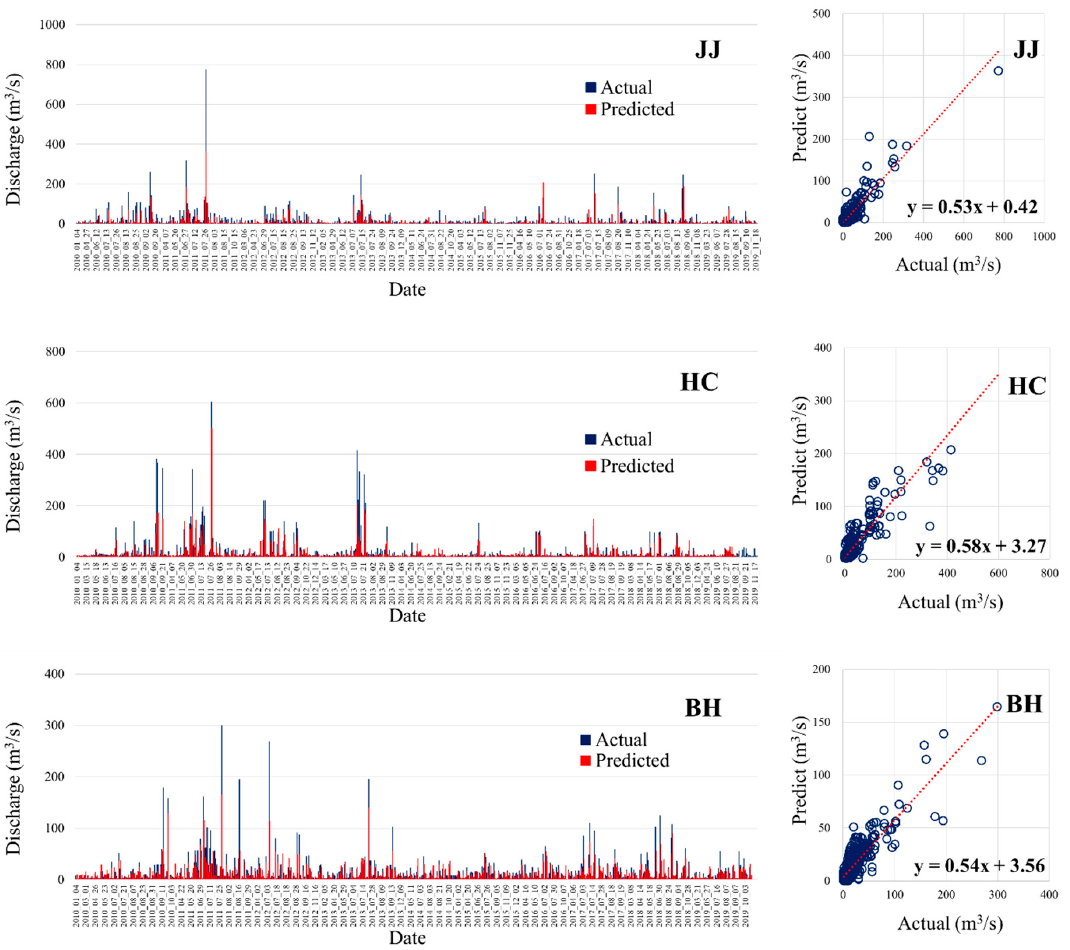
Figure 9. Changes and dispersion of the prediction results of the CNN model: ( a ) Case 1 (JJ discharge simulation), ( b ) Case 2 (HC discharge simulation), and ( c ) Case 3 (BH discharge simulation).